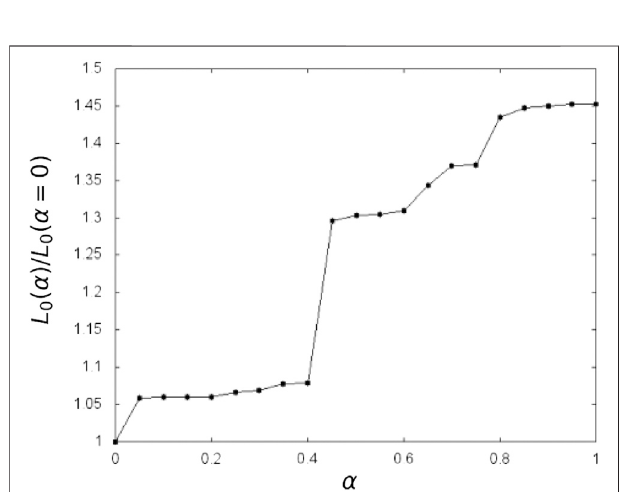
FIGURE 6 | The length of the optimal paths, L O between the lower left and upper right corner of V as a function of α , while keeping β (cid:3)